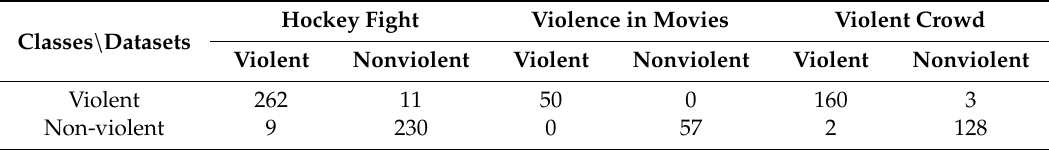
Table 7. Confusion matrix for each dataset.